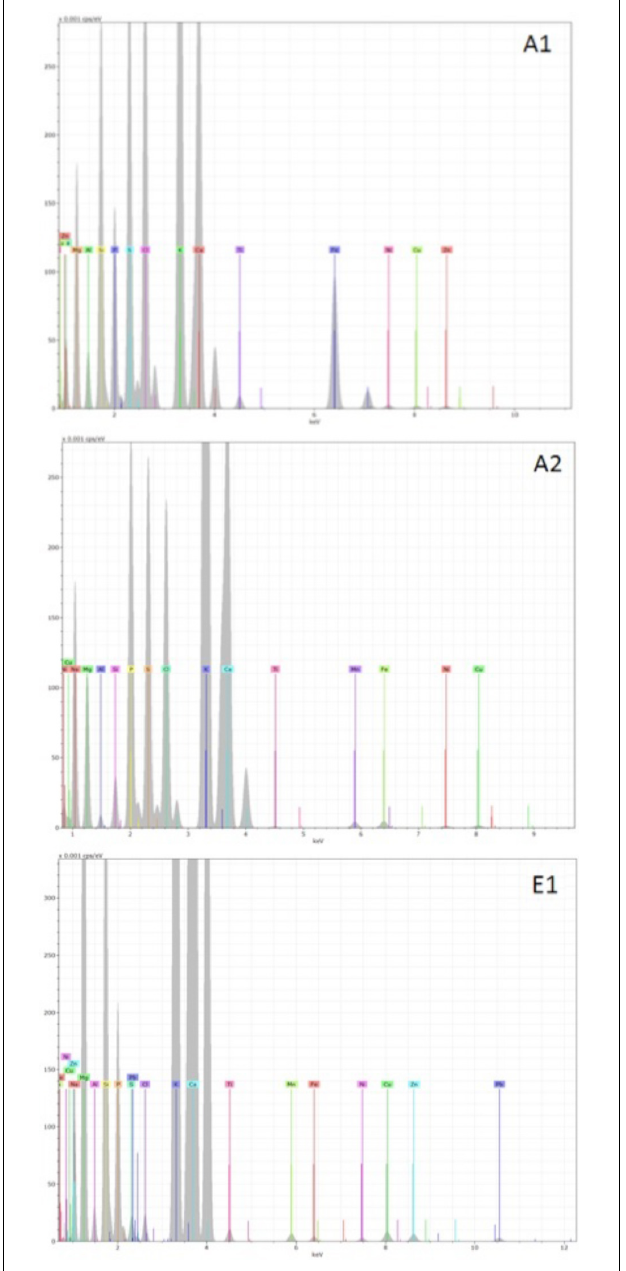
FIGURE 7 | Deconvoluted X-ray emission spectra acquired from biochars A1, A2, and E1. The electron beam energy was set at 20 KV and the acquisition live time at 60 s. In each spectrum, the X axis represents the X-ray energy in eV, and the Y axis represents the peak